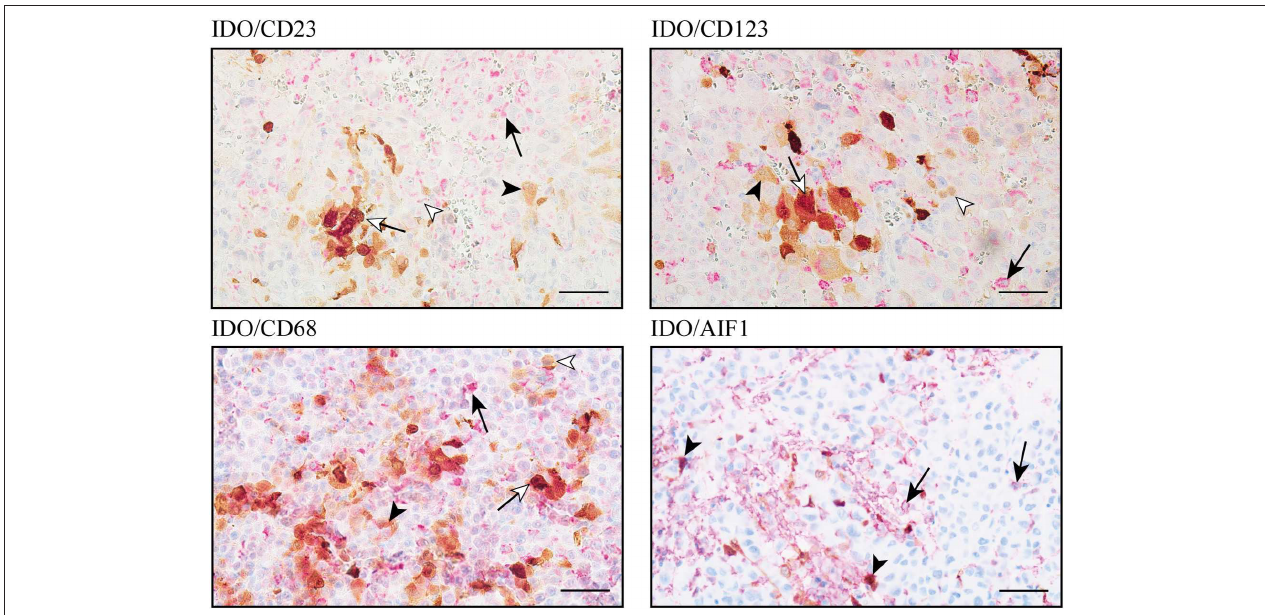
FIGURE 8 | IDO-expression on cellular components of the immunoreactive tumor infiltrate in melanoma metastases of the central nervous system. Immunohistochemical-based co-immunostaining for IDO (brown) and indicated makers for subpopulations of DC and macrophages/microglia (all in red) exemplarily shown in intracranial (right) metastases. Black arrowhead: IDO + macrophage; black arrow: single expression of the indicated markers (CD23, CD123, CD68, or AIF1); white arrow: co-expression of IDO plus indicated maker in macrophages, white arrowhead: single marker detection. Representative images were presented. Scale bar = 50 µ